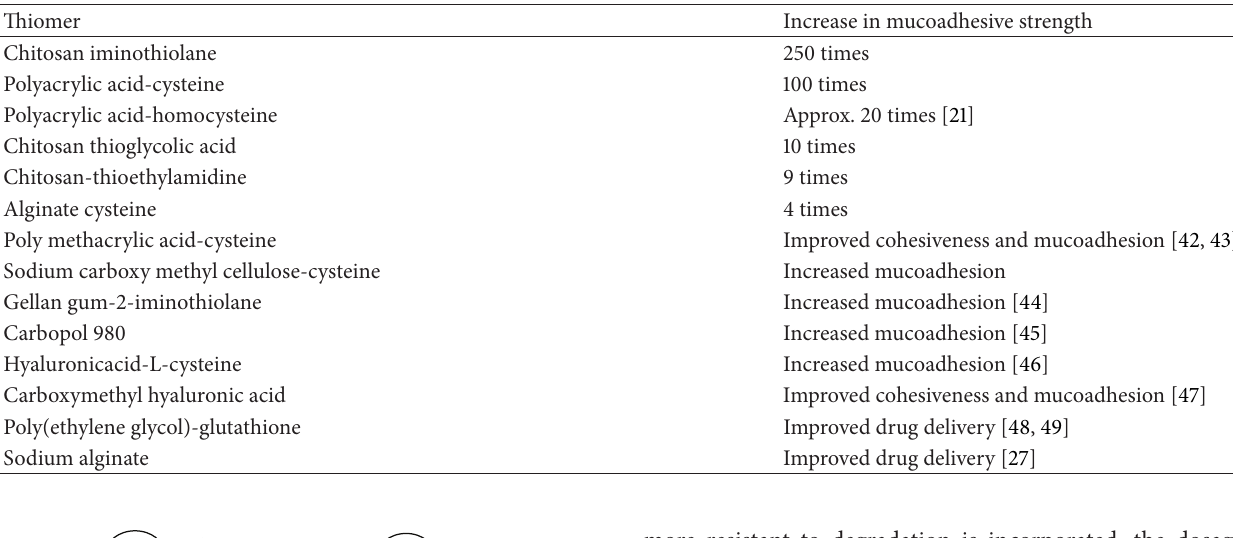
Table 2: Thiomers with their effect on mucoadhesion [11].